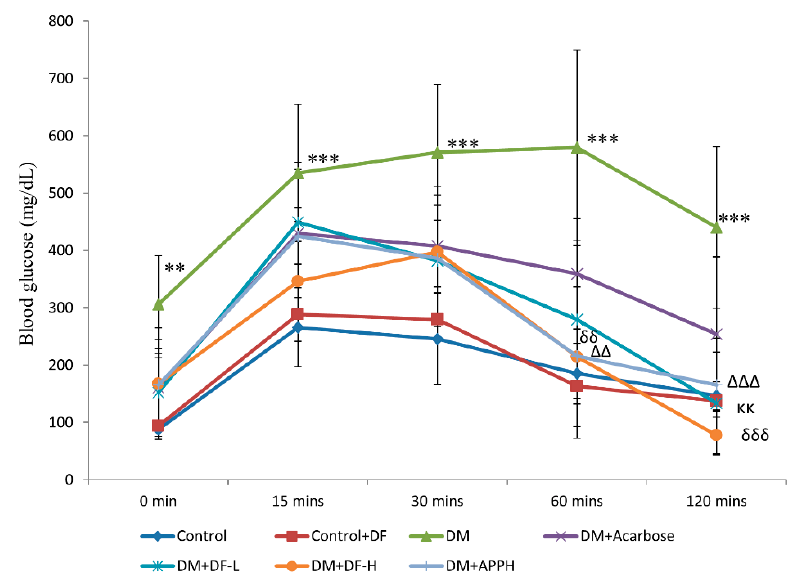
Figure 2. Changes in blood glucose level observed with oral glucose tolerance test (OGTT). OGTT results after 4 weeks of treatment show differences in blood glucose levels in non-diabetic